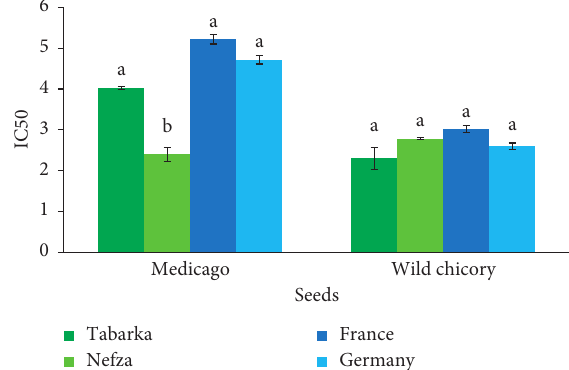
Figure 5: IC 50 of the ethanolic extract according to the origin of M. officinalis and seeds. Values followed by the same letters are not significantly different ( P > 0 . 05).